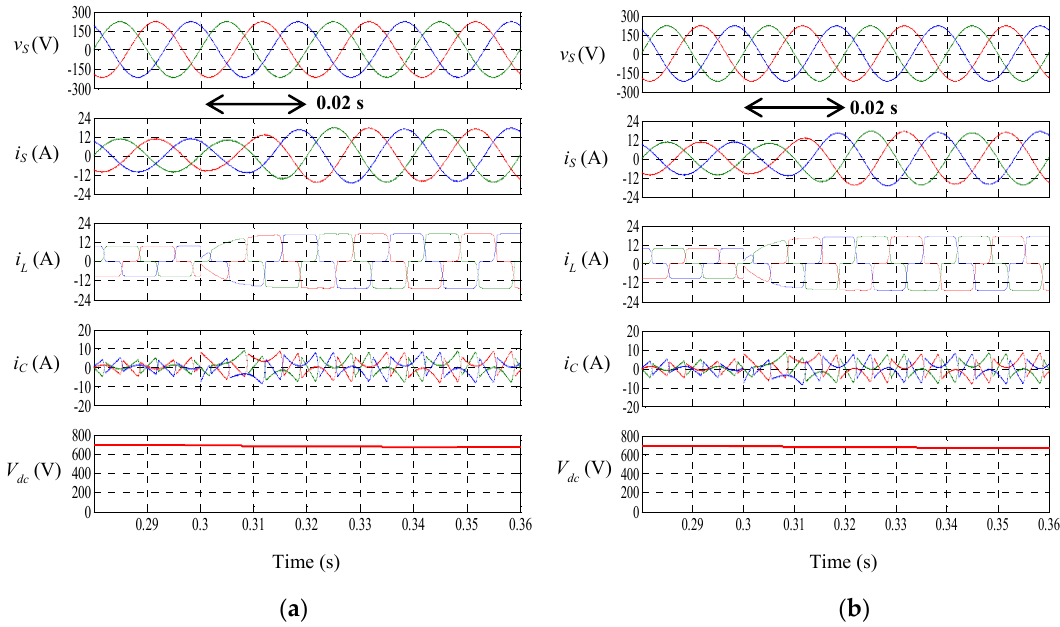
Figure 11. Simulation result of SAPF which includes the three-phase source voltage v S , source current i S , compensation current i C , and DC bus voltage V dc , obtained from SAPF ( a ) with FLC and ( b ) without FLC. Energies 2017 , 10 , 758